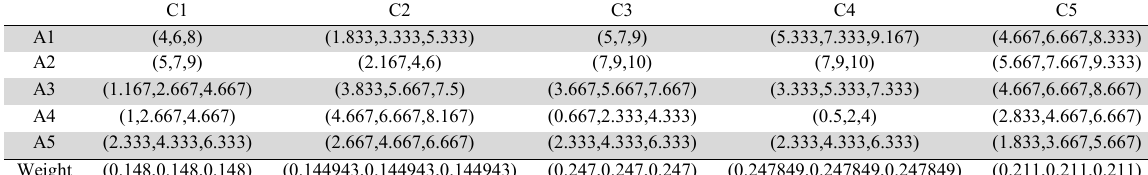
Aggregated triangular fuzzy decision matrix